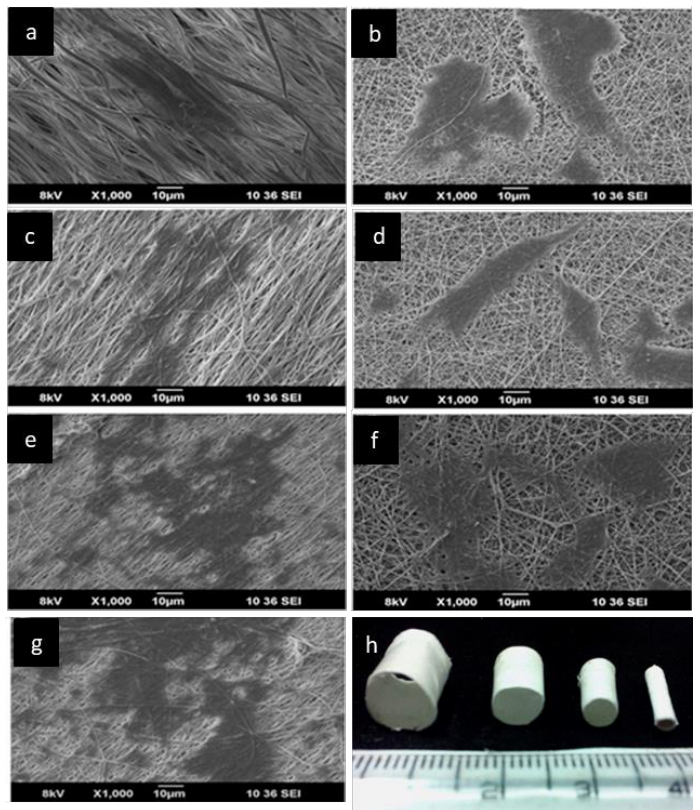
Figure 18. SEM image of SMCs on the surface of the scaffolds after 120 h ( a ) PLLA alone, ( b ) nonwoven PLLA with 5% gelatin, ( c ) aligned PLLA with 5% gelatin, ( d ) nonwoven PLLA with 10% gelatin, ( e ) aligned PLLA with 10% gelatin ( f ) nonwoven PLLA with 20% gelatin and ( g ) aligned PLLA with 20% gelatin. ( h )The electrospun PLLA/gelatin tubular constructs. Reproduced with permission from [149] (License number: